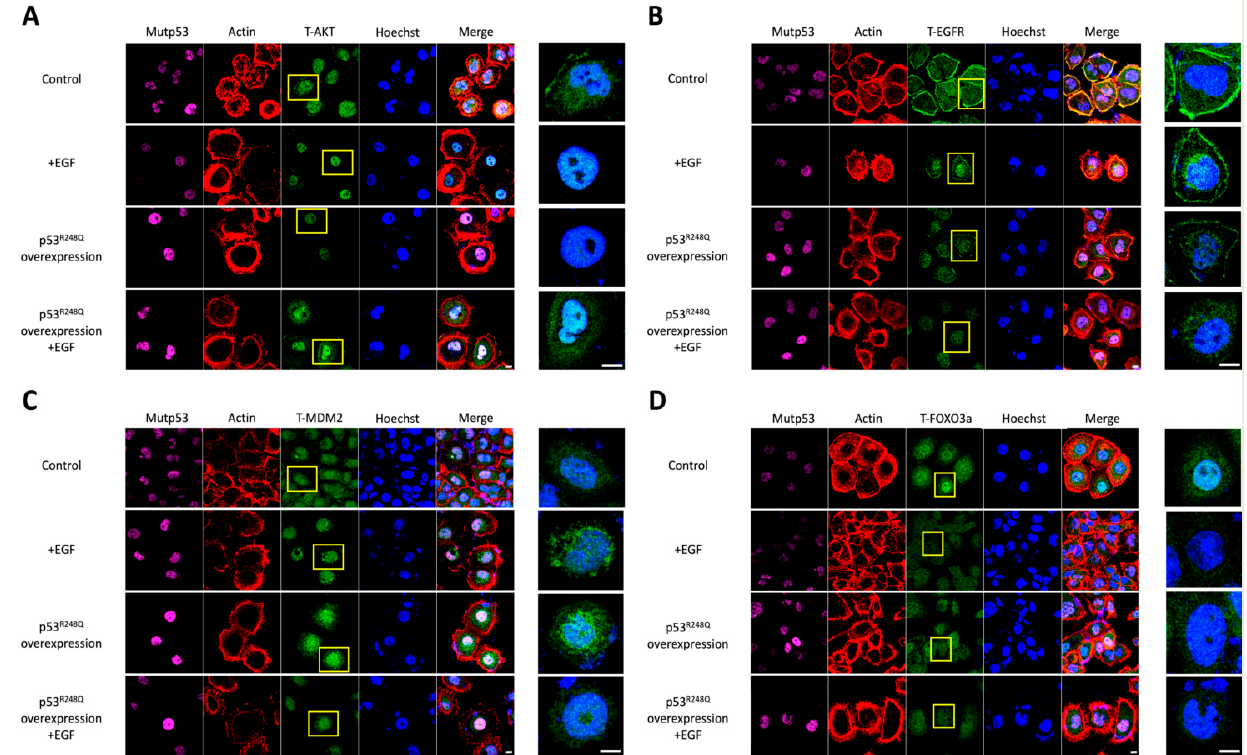
Figure 2. p53 R248Q overexpression and EGF stimulation altered the intracellular localization patterns of AKT, EGFR, MDM2 and FOXO3a. In this experiment, we first transfected OVCAR3 cells with or without the p53 R248Q expression plasmid (1 μ g/mL) for 24 h and then serum-starved the cells for another 24 h. Before confocal imaging, we stimulated the cells in the presence or absence of EGF (50 ng/mL) for 15 min. That is, the following four conditions were analyzed: the “control” group, in which the cells were serum-starved only; the “+EGF” group, in which the cells were treated with EGF after serum starvation; the “p53 R248Q overexpression” group, in which the cells were transfected with p53 R248Q before serum starvation; and the “p53 R248Q overexpression + EGF” group, in which the cells were transfected with p53 R248Q , serum-starved, and then treated with EGF. Since the cells were only transiently transfected with p53 R248Q , we immunostained the cells with an anti-mutant p53 antibody to ensure that the transfected cells overexpressed p53 R248Q . ( A ) Confocal image analysis revealed that most AKT translocated into the nucleus completely after EGF stimulation or p53 R248Q overexpression. However, when the cells were overexpressed with p53 R248Q and then stimulated with EGF, some AKT remained in the cytoplasm. ( B ) In the control group, most EGFR accumulated on the cell membrane, while some EGFR distributed evenly in the cytoplasm. After EGF stimulation or p53 R248Q overexpression, EGFR appeared to converge and translocate towards the nucleus. When overexpressed with p53 R248Q and then stimulated with EGF, EGFR could not be detected on the cell membrane. ( C ) In the control group, MDM2 could be detected in the cytoplasm. After EGF stimulation, MDM2 dynamically converged around the nucleus. Such phenomena could also be observed after overexpression of p53 R248Q . With both p53 R248Q overexpression and EGF stimulation, MDM2 translocated into the nucleus. ( D ) FOXO3a, which mostly accumulated in the nucleus in the control group, was evenly distributed in the cytoplasm after treatment with either EGF stimulation, p53 R248Q overexpression, or both. The cells were immunostained with anti-AKT antibody, anti-EGFR antibody, anti-MDM2 antibody, anti-FOXO3a antibody (shown in green), and anti-mutant p53 antibody (shown in purple); actin in red and DNA in blue were shown by Phalloidin staining and Hoechst staining, respectively. The right images were enlarged view of the yellow boxed region. The scale bar represented 10 μ m.